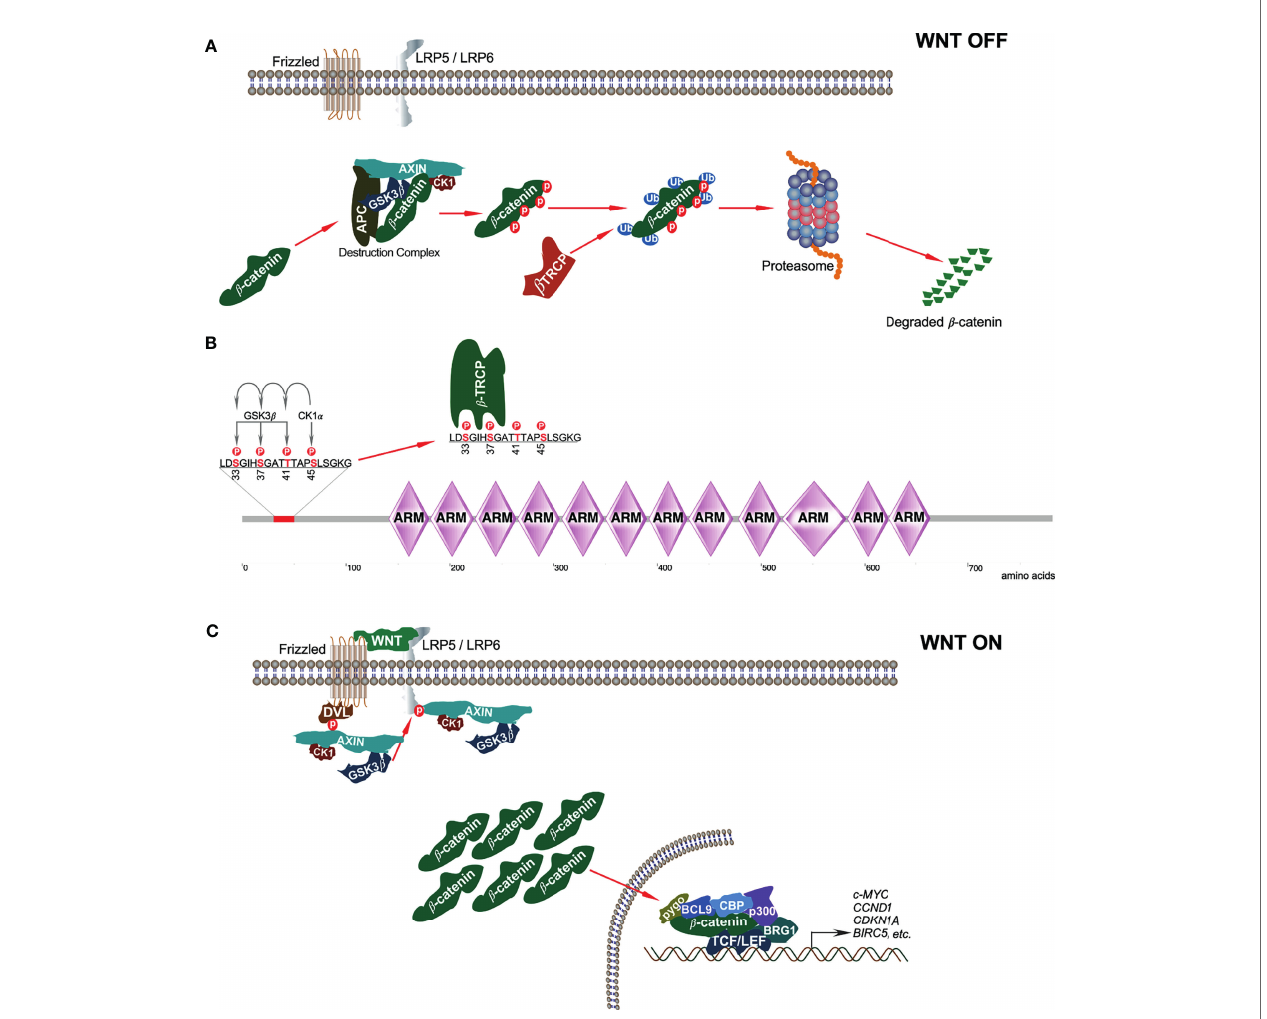
FIGURE 2 | Canonical WNT signaling. (A) In absence of canonical WNT ligands, b -catenin is associated with the destruction complex. This interaction leads to phosphorylation-dependent ubiquitination of b -catenin and thereby its degradation in the proteasome. (B) In the destruction complex, CK1 a phosphorylates b -catenin on Ser45 residue that initiates sequential phosphorylation of Thr41, Ser37, and Ser33 phosphorylation by GSK3 b . Ser33 and Ser37 phosphorylation sites facilitate b -TRCP interaction with b -catenin. (C) In the presence of classical WNT ligands, a destruction complex cannot be formed and thus, b -catenin is stabilized from